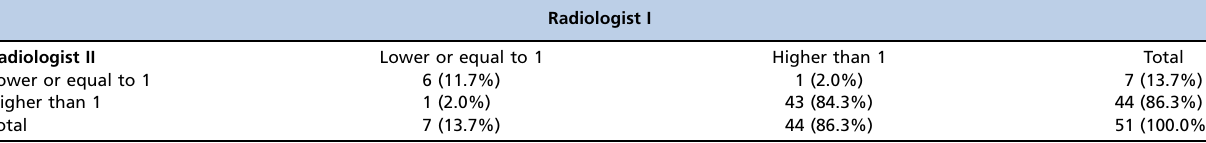
Table 1 - Agreement between Pelvic–Trochanteric Index measurements taken from the two